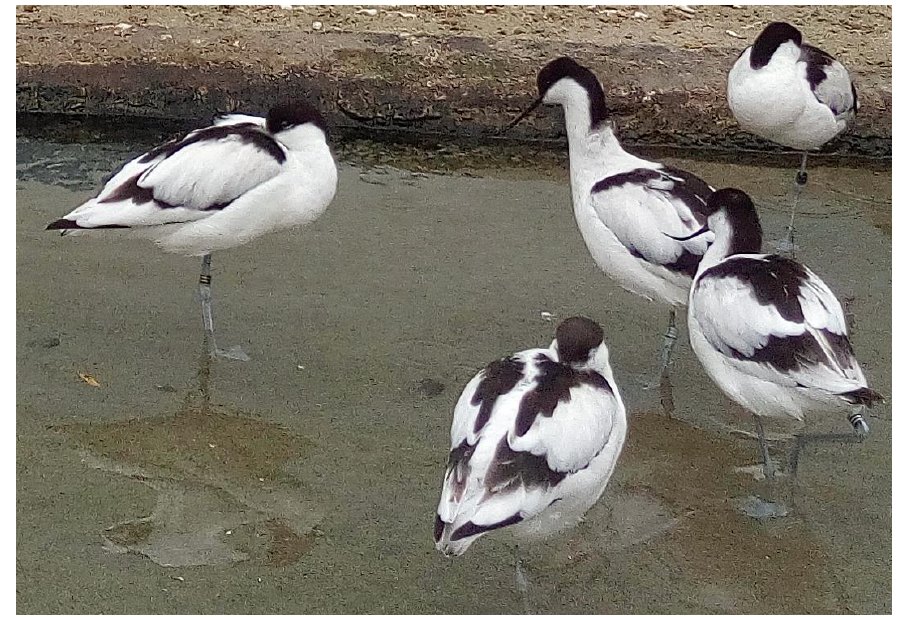
Figure 1. Pied avocets.